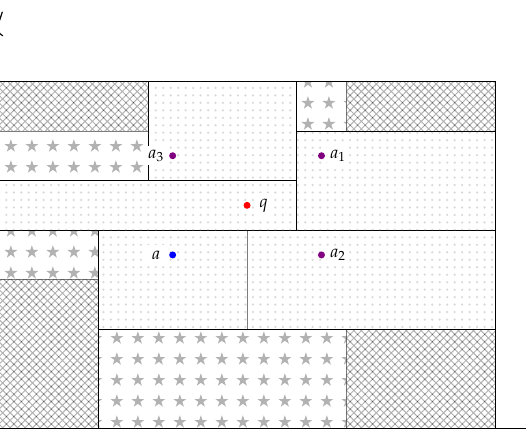
Figure 5. Clipping technique. The rectangles show the buckets of our LSD tree. Given we have a query point q and found a neighbor a of q , we mirror a to all remaining 3 orthants across q , which gives us a 1 , a 2 , and a 3 . We have to scan or have already scanned the light dotted buckets but can omit, thanks to these four points, the cross-hatched buckets. The buckets with stars may still store skyline points, so we have to scan